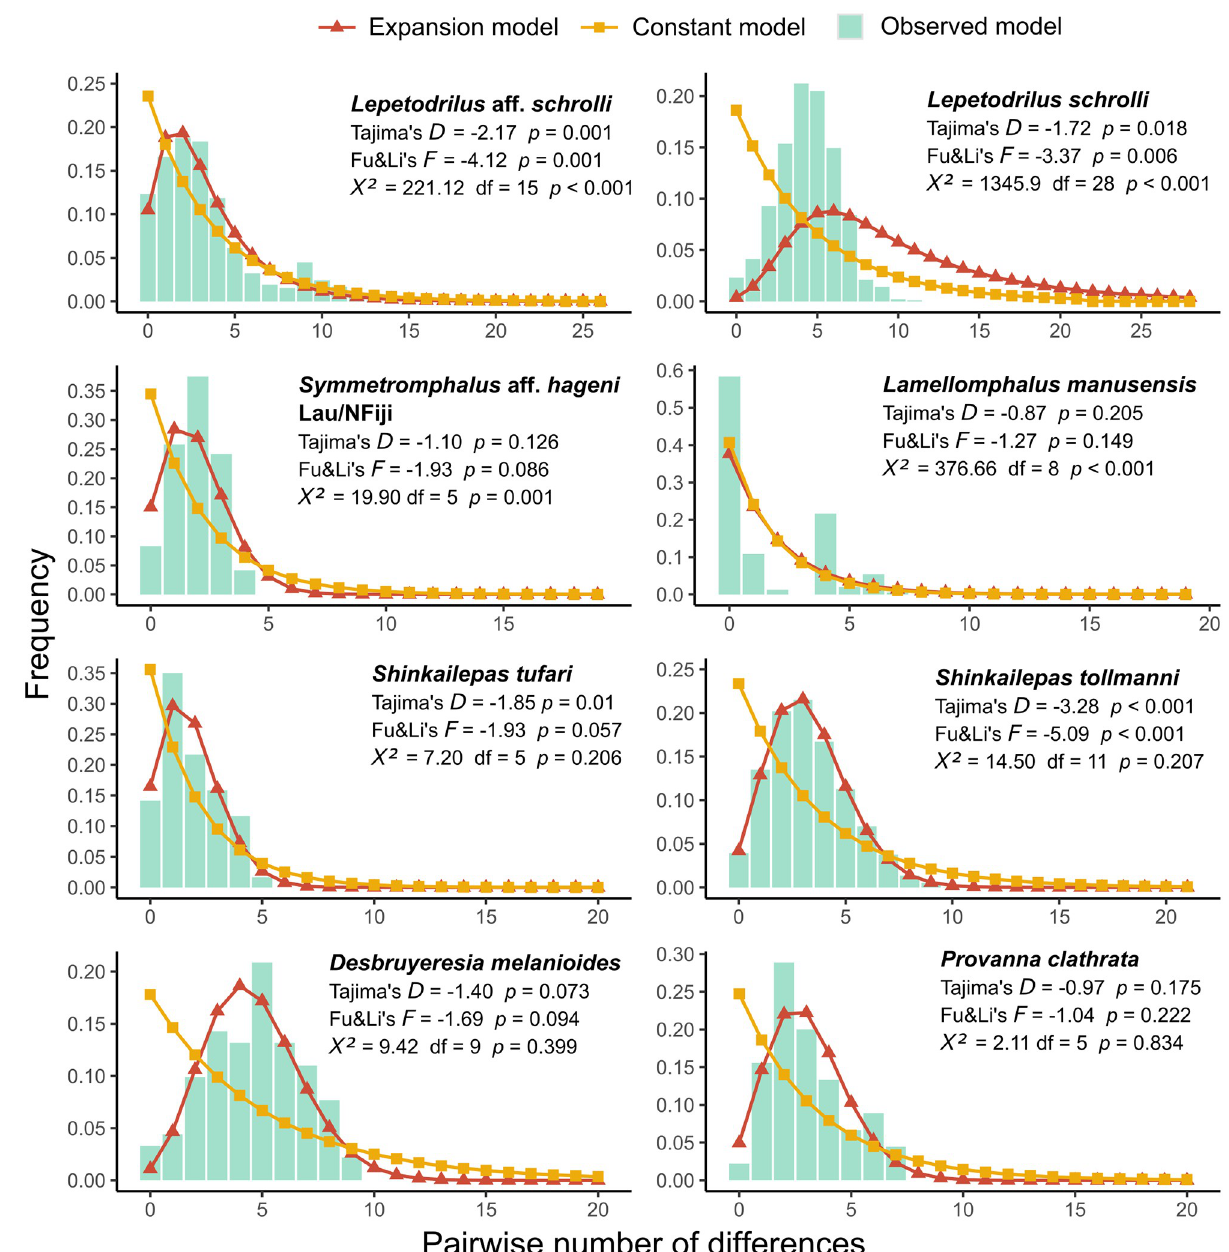
Fig 5. Observed and simulated match-mismatch curves. The chi-square goodness of fit test results presented compare the observed distribution to the expected under an expanding population one. Results of chi-squared test comparing the observed distribution to the expected under a constant population one (not shown in the figure) always indicated that observed distribution did not fit the expected one ( p < 0.001).